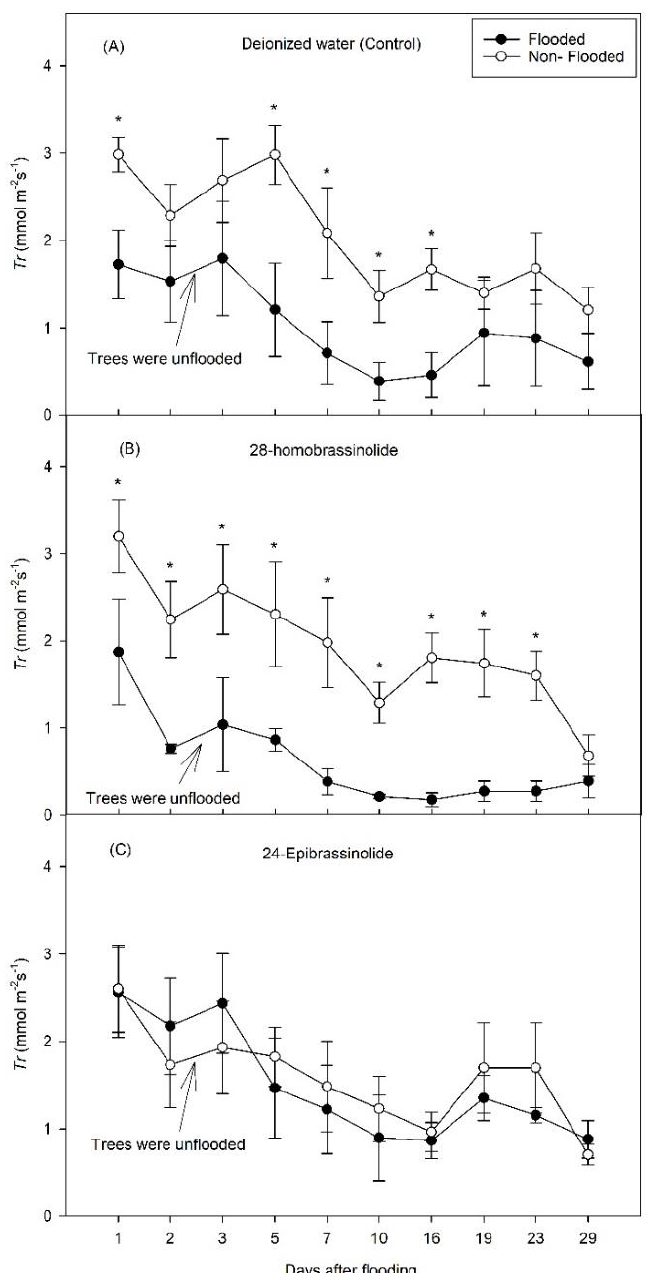
Figure 3. Effect of flooding on transpiration ( Tr ) of ‘Monroe’ avocado trees treated with ( A ) deionized water as a control, ( B ) 28-homobrassinolide, or ( C ) 24-epibrassinolide (Experiment 1). Symbols and bars indicate means ± std. err. Significant differences ( p ≤ 0.05) between flooding treatments are indicated with an asterisk and were determined by repeated-measures ANOVA. ‘Trees were unflooded’ indicates the day on which trees were removed from the flooding treatment to start the recovery period.